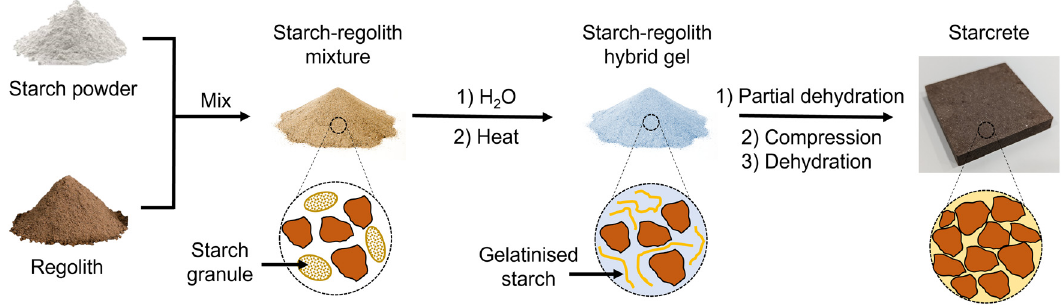
Figure 2: Scheme depicting the steps taken to produce StarCrete.